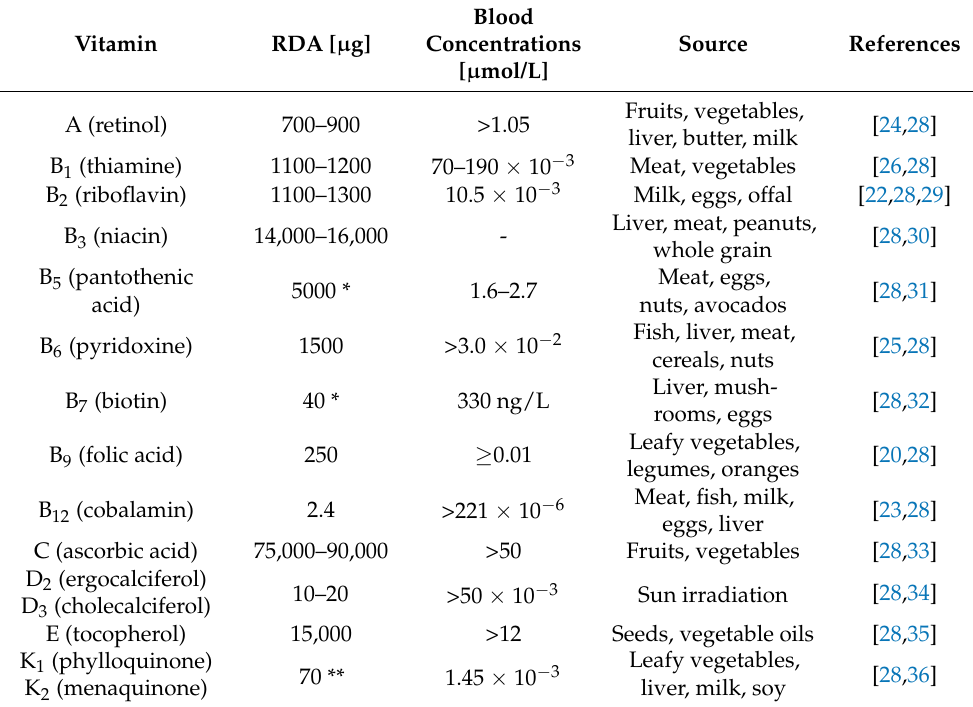
Table 1. Summary of the vitamins reported in the present review.